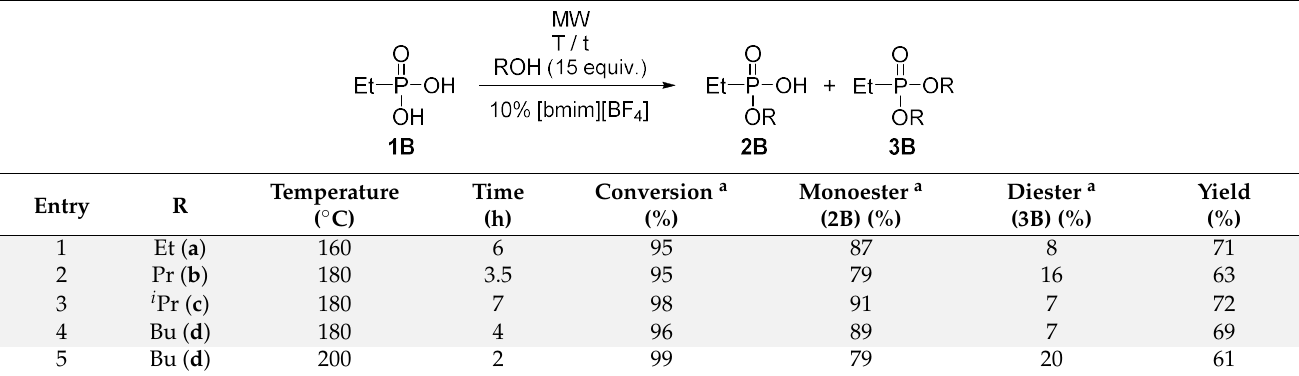
Table 2. Direct esterification of ethylphosphonic acid ( 1B ) in the presence of [bmim][BF 4 ] on MW irradiation.